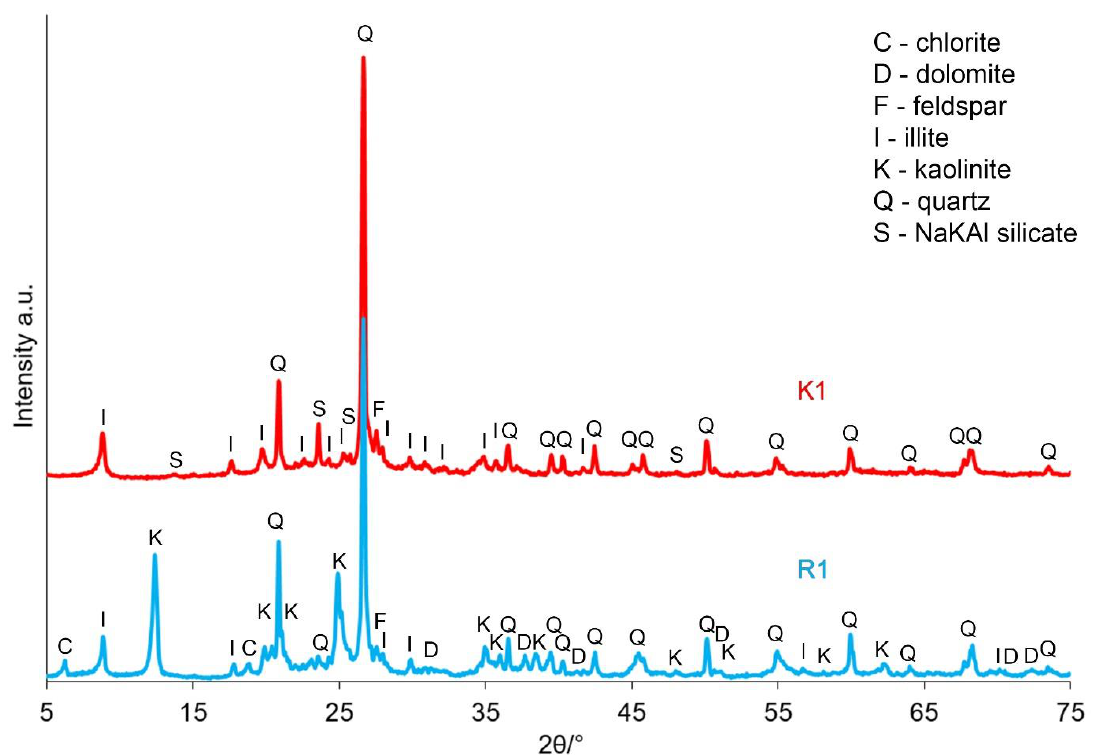
Figure 3. XRD patterns of a sample taken from the Piast hard coal mine, both before (R1) and after the calcination process (K1).